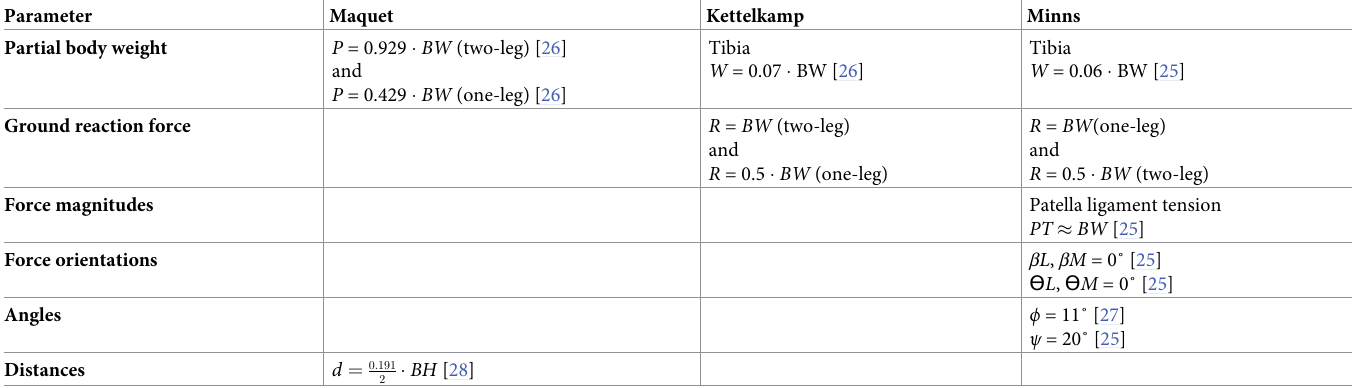
Table 1. Assumptions made for